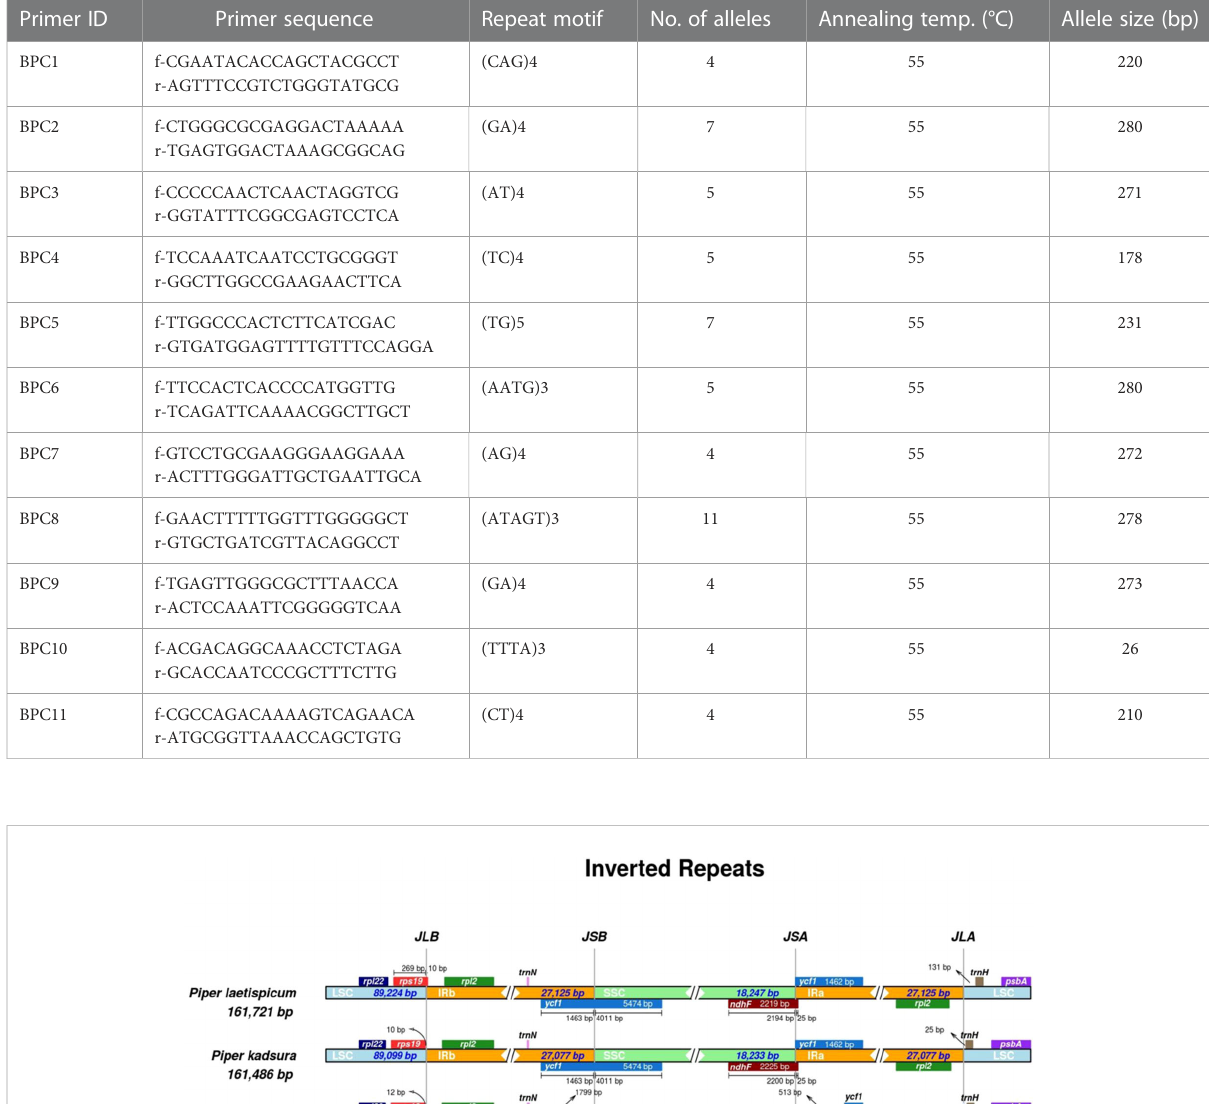
TABLE 5 Details of 11 chloroplast SSR primers validated in 12 Piper species (21 accessions). Primer ID Primer